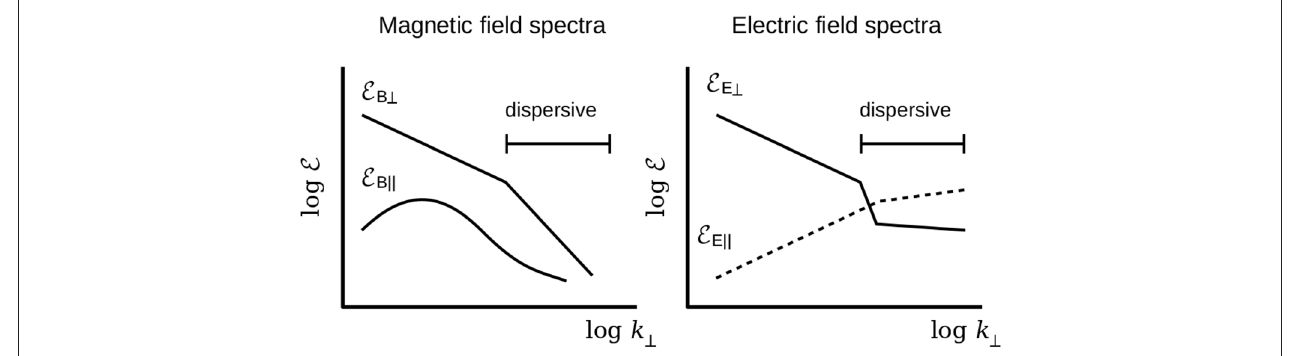
FIGURE 7 | Schematic energy spectra for the magnetic field (left) and electric field (right) of the kinetic Alfvén mode in the perpendicular wavenumber domain.